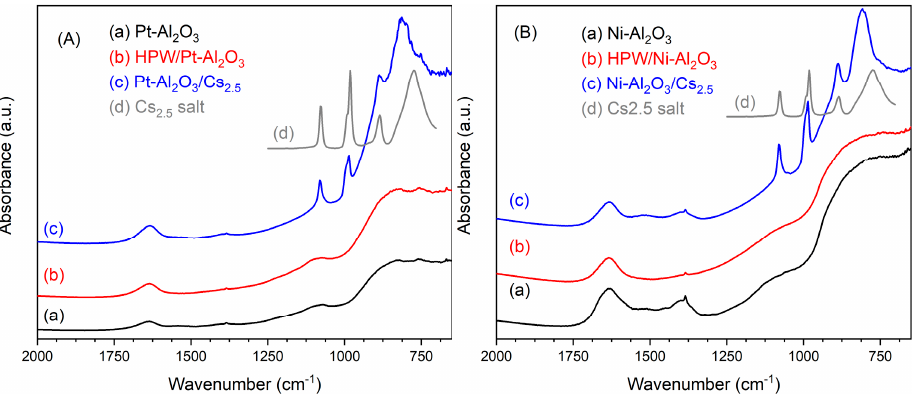
Figure 2. Infrared spectra of the different catalyst: ( A ) Pt-Al 2 O 3 series; ( B ) Ni-Al 2 O 3 series. Infrared spectrum of Cs 2.5 salt has been added in both the series for better comparison.